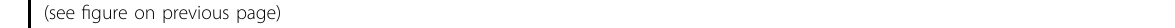
Fig. 4 HRD1 modulates NRF2 through ubiquitination degradation. A Colocalization of HRD1 and NRF2 in H/R-exposed TCMK-1 cells. Confocal microscopy analysis; Pearson ’ s correlation coef fi cient; scale bar = 50 μ m; ×600 magni fi cation. ** P < 0.01 vs. normal control group ( n = 6). B HRD1 and NRF2 coexisted in the precipitated complexes of H/R-exposed TCMK-1 cells. IP immunoprecipitation, IB immunoblot,. C Silencing of HRD1 led to an increase in NRF2 level, while overexpression of HRD1 caused a reduction in NRF2 level. D HRD1 overexpression promoted NRF2 ubiquitylation and degradation, and subsequently reduced NRF2 level in HEK-293T cells. E The QSLVPDI motif on NRF2 constituted an active site for its interaction with HRD1. F The deletion of QSLVPDI amino acids sequence ( Δ 125 – 131) remarkably decrease ubiquitylation of NRF2 mediated by HRD1. G Graphical illustration of the working mechanism: XBP1/HRD1 is involved in IR-induced AKI through the regulation of NRF2/HO-1-mediated ROS